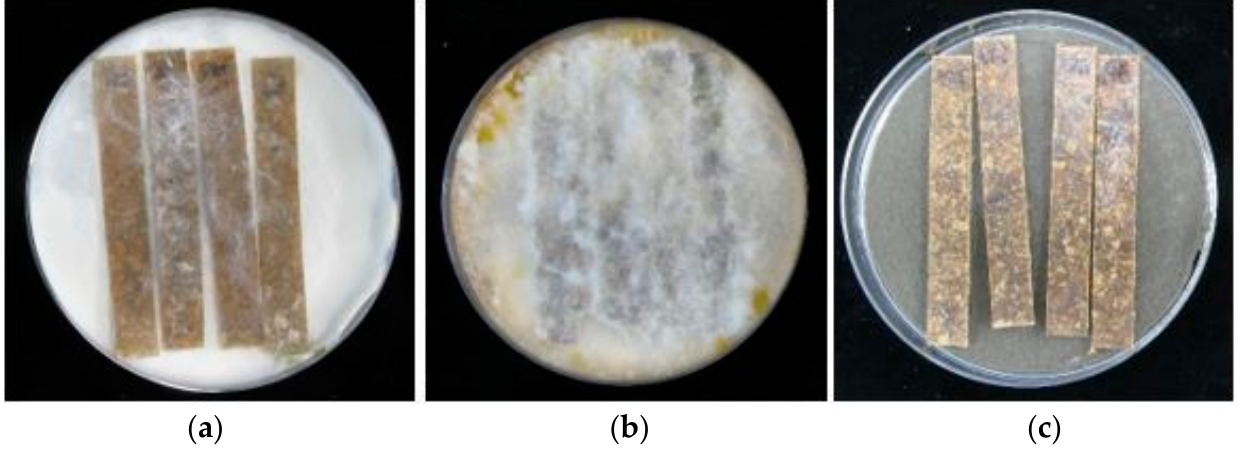
Figure 5. Composite samples (PP+W+EEP+silanes) after UV aging (30 days) and exposure to ( a ) C. puteana , ( b ) C. versicolor , and ( c ) Ch. globosum.